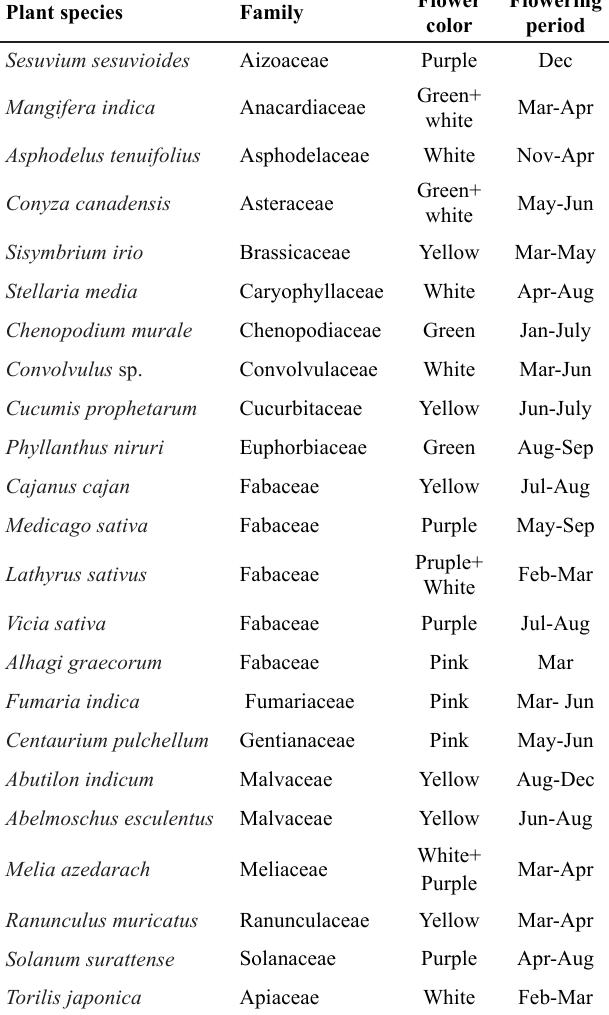
Table 2 . Plant species which were not visited by A. dorsata and A. florea during January to December, 2008.